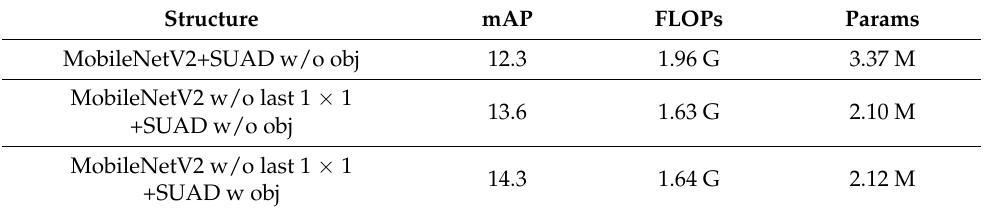
Table 4. Evaluation of simultaneous upsampling and detection module with MobileNetV2 Backbone and evaluation of the influence of the last convolutional layer on the MobileNetV2